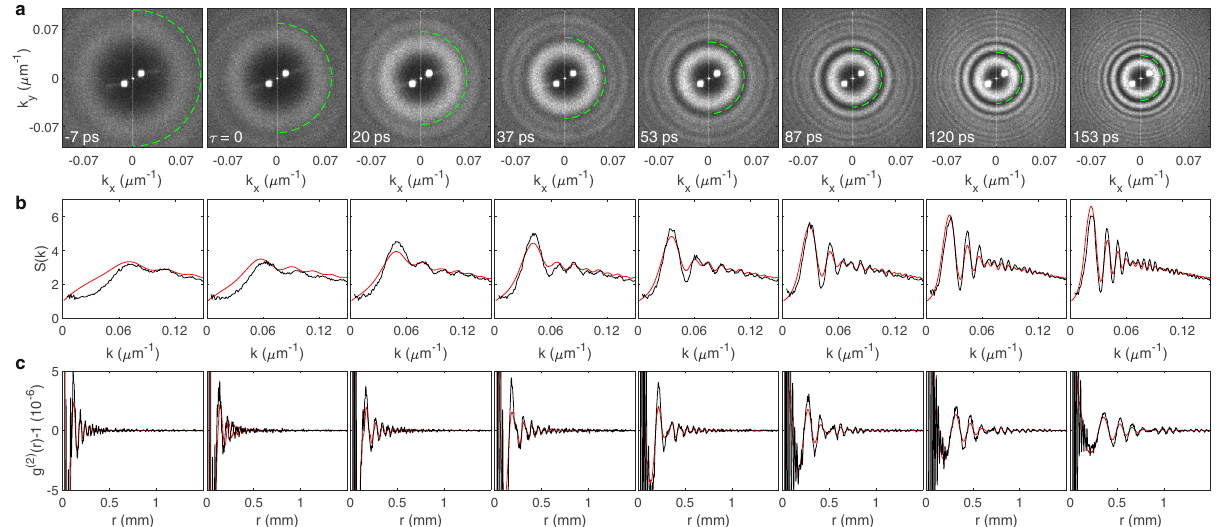
Fig. 2 Analogue cosmological particle creation in a quantum fl uid of light. a The static structure factor S ( k x , k y , k z ′ = 0) at various times after the second quench. The dashed green curves indicate the fi rst minimum of the red curves in ( b ). The symmetric white points near the center of all panels are due to spurious fringes in the imaging system. b Radial pro fi les of ( a ). The black curves are the experimental data. The red curves are the prediction for analogue cosmological particle creation, from Eq. (2). c Density-density correlations. The experimental (black) and theoretical (red) curves are obtained from b by the spherical Fourier transform of Eq.